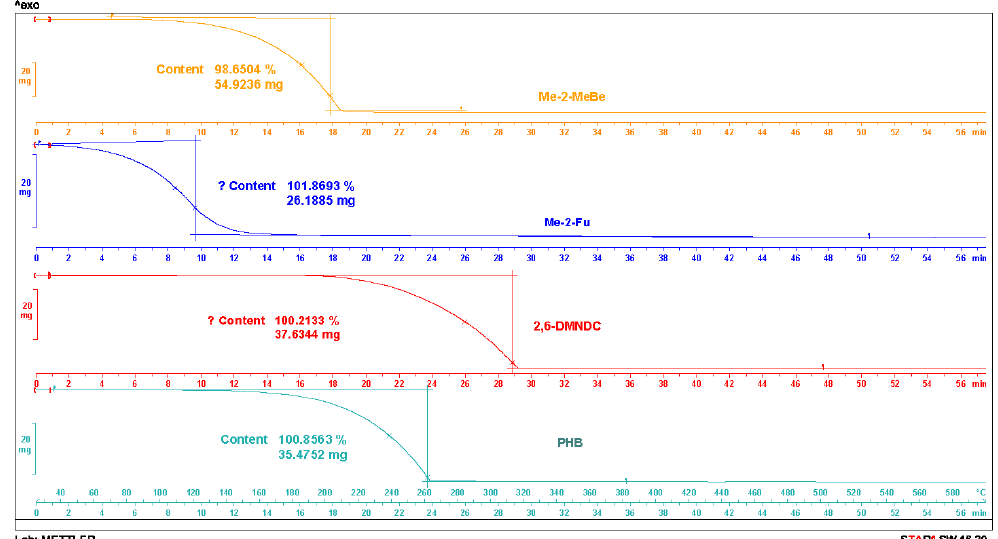
Figure A5. TGA data of Me-2-MeBe, Me-2-Fu, 2,6-DMNDC and PHB.